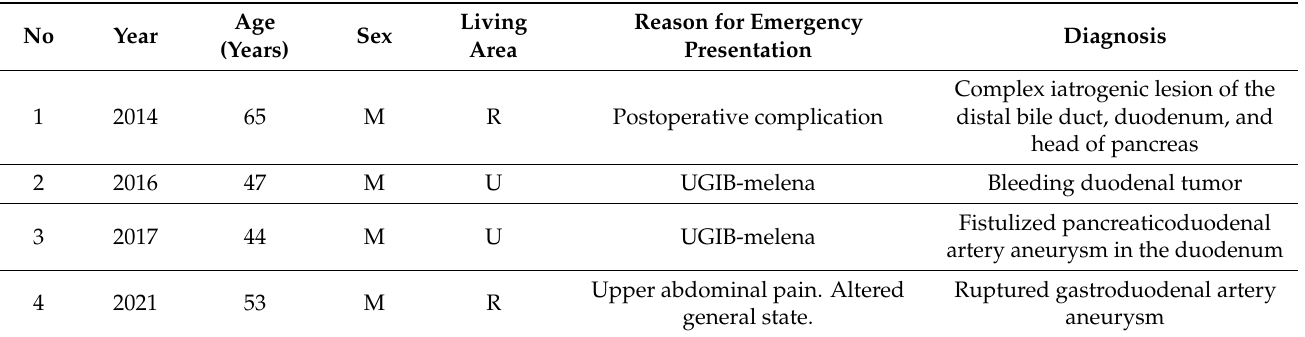
Table 1. Demographic details, motive of presentation and